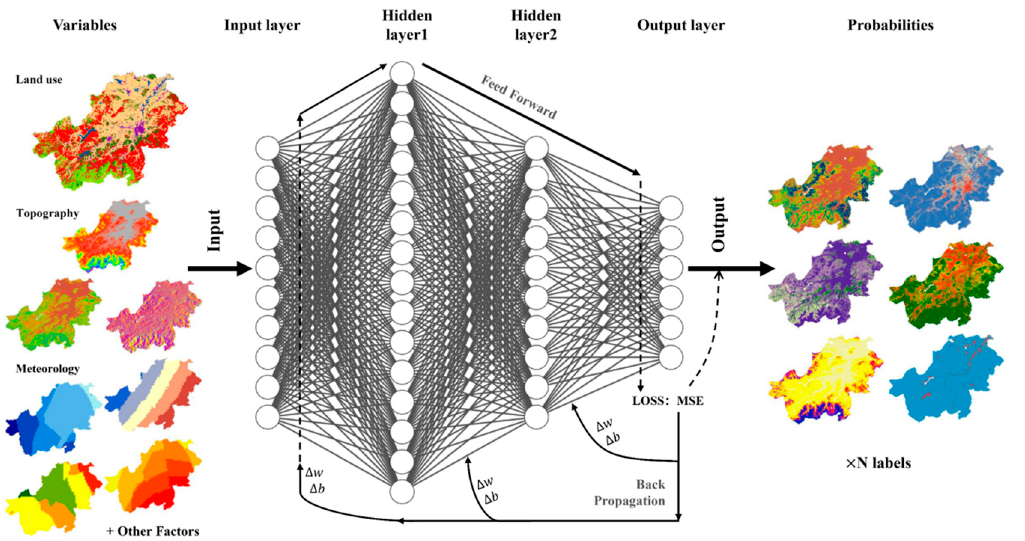
Table 3. The neighborhood weights for individual land-use type.